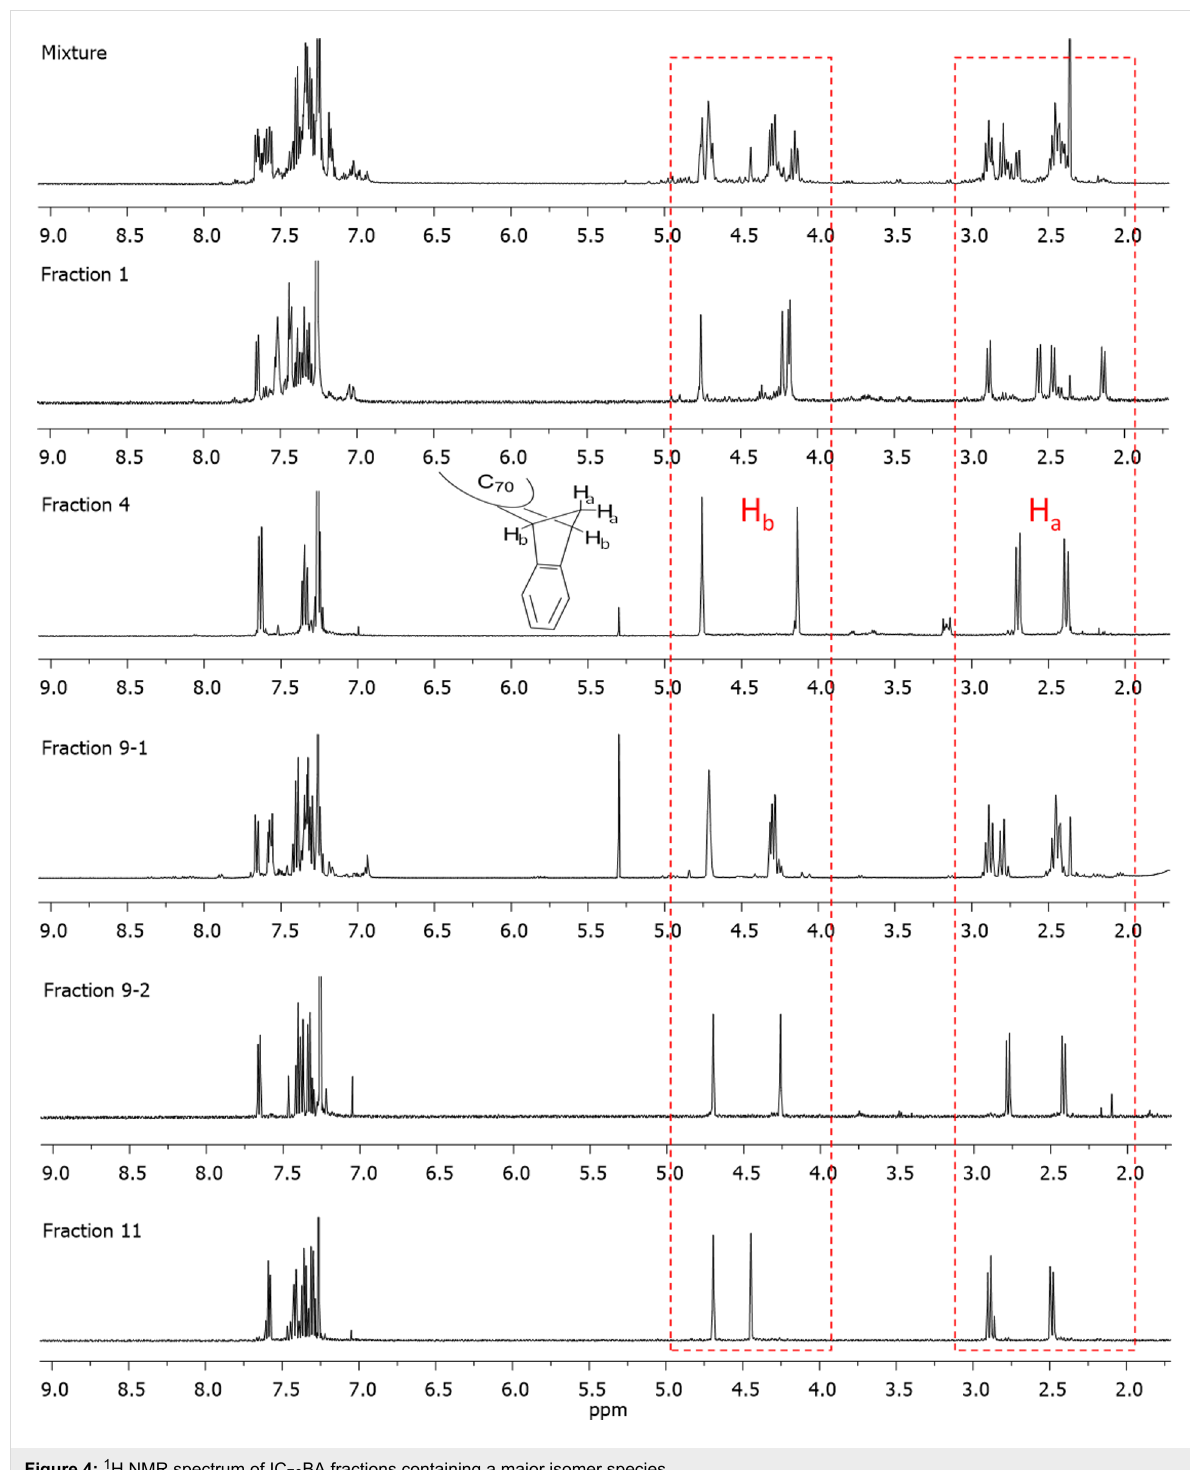
with neighboring fractions. In those cases, the 1 H NMR experi- ments did not provide useful information for identifying the configuration of isomers contained in the samples (see Support- ing Information File